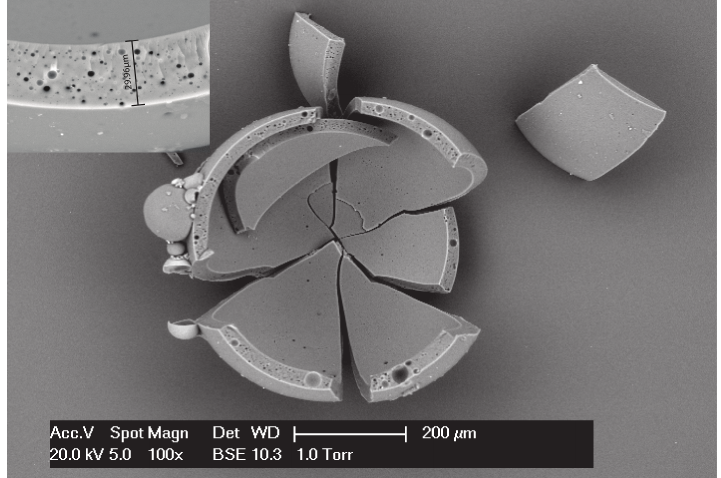
Figure 5. Morphology of a ruptured PF microcapsule. Inset is an enlarged image showing the thickness and structure of the shell of synthesized PF